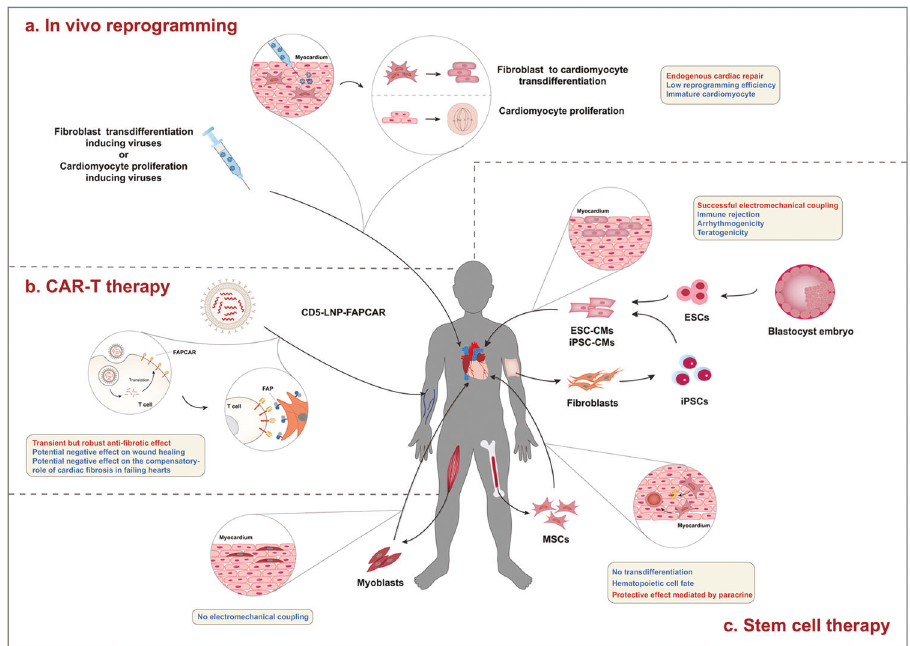
Fig. 6 Summary of therapeutic strategies based on cell therapy for failing hearts. The earliest attempt is myoblast transplantation to the injured heart. However, these cells don ’ t form connection with neighboring cardiomyocytes. Transplantation of bone marrow derived mesenchymal stem cell (BMSC) shows modest bene fi t, which is mediated by paracrine factors secreted by BMSC instead of transdifferentiation into cardiomyocytes. Transplantation of inducible pluripotent stem cell derived cardiomyocytes (iPSC-CM) or embryonic stem cell derived cardiomyocytes (ESC-CM) successfully achieve electromechanical coupling between the transplanted and in situ cardiomyocytes, but these therapies have the shortcomings of immune rejection, arrythymogenicity, and teratogenicity. In vivo reprograming tries to induce fi broblast-to-cardiomyocyte transdifferentiation or cardiomyocyte proliferation by gene manipulation to compensate for cardiomyocyte loss. Chimeric antigen receptor (CAR) T cell therapy targeting activated fi broblast has been just proposed by a proof-of- concept study. These CAR T cells can be induced by injection of modi fi ed RNA loaded in T cell directed lipid nanoparticles. LNP: lipid nanoparticle; FAP: fi broblast activation protein; iPSC: induced pluripotent stem cell; ESC: embryonic stem cell; MSC: mesenchymal stem